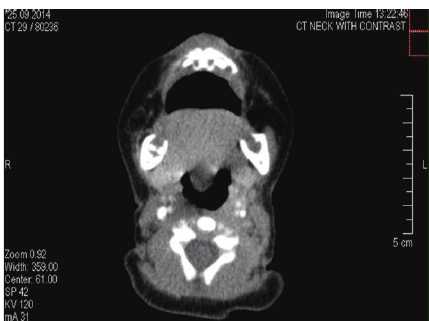
Figure 1: Flexible upper endoscopy showing a vallecular cyst obstructing the airway.